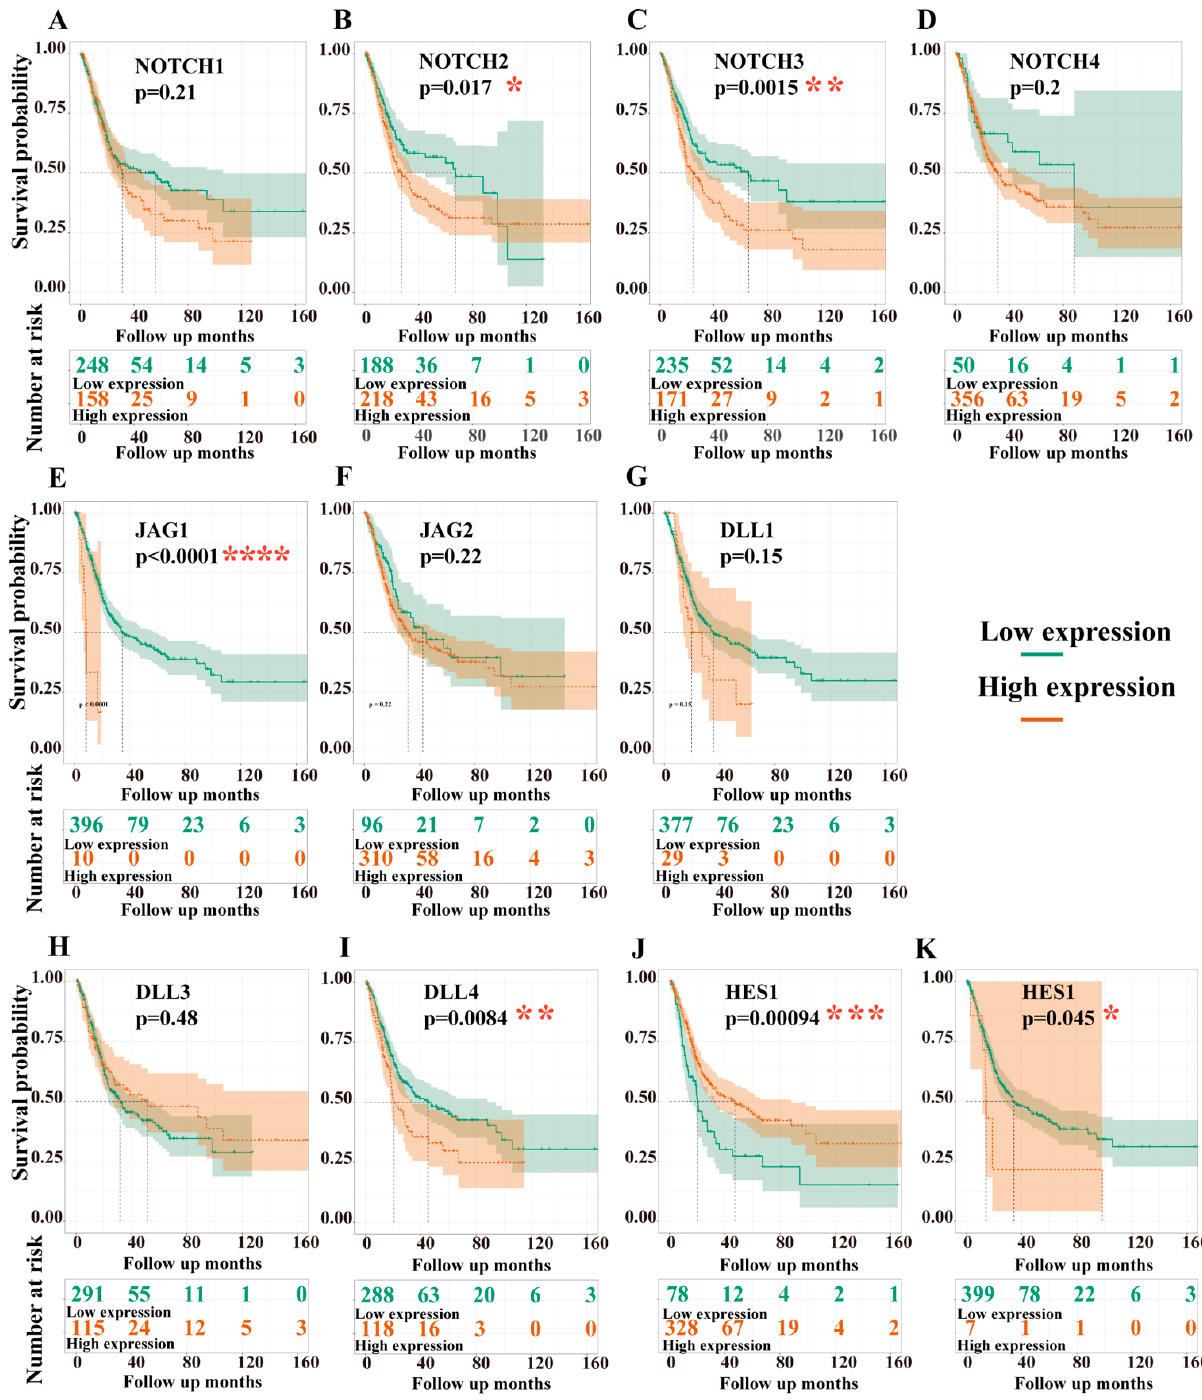
Figure 6. Overall survival analyses of the target genes. NOTCH1 ( A ), NOTCH2 ( B ), NOTCH3 ( C ), NOTCH4 ( D ), JAG1 ( E ), JAG2 ( F ), DLL1 ( G ), DLL3 ( H ), DLL4 ( I ), HES1 ( J ), and HEY1 ( K ); data from TCGA-BLCA, n = 406; dead, n = 179; alive, n = 227; see Table S6 for threshold (cut-off value) used to define the high and low levels of the expression. y -axis = overall survival probability, x -axis = follow up in days, high expression (orange line), low expression (green line); the number at risk in high- and low-expression groups are listed in the tables below the survival curve; significance levels are marked as * p -value < 0.05, ** p -value < 0.01, *** p -value < 0.001, **** p -value <